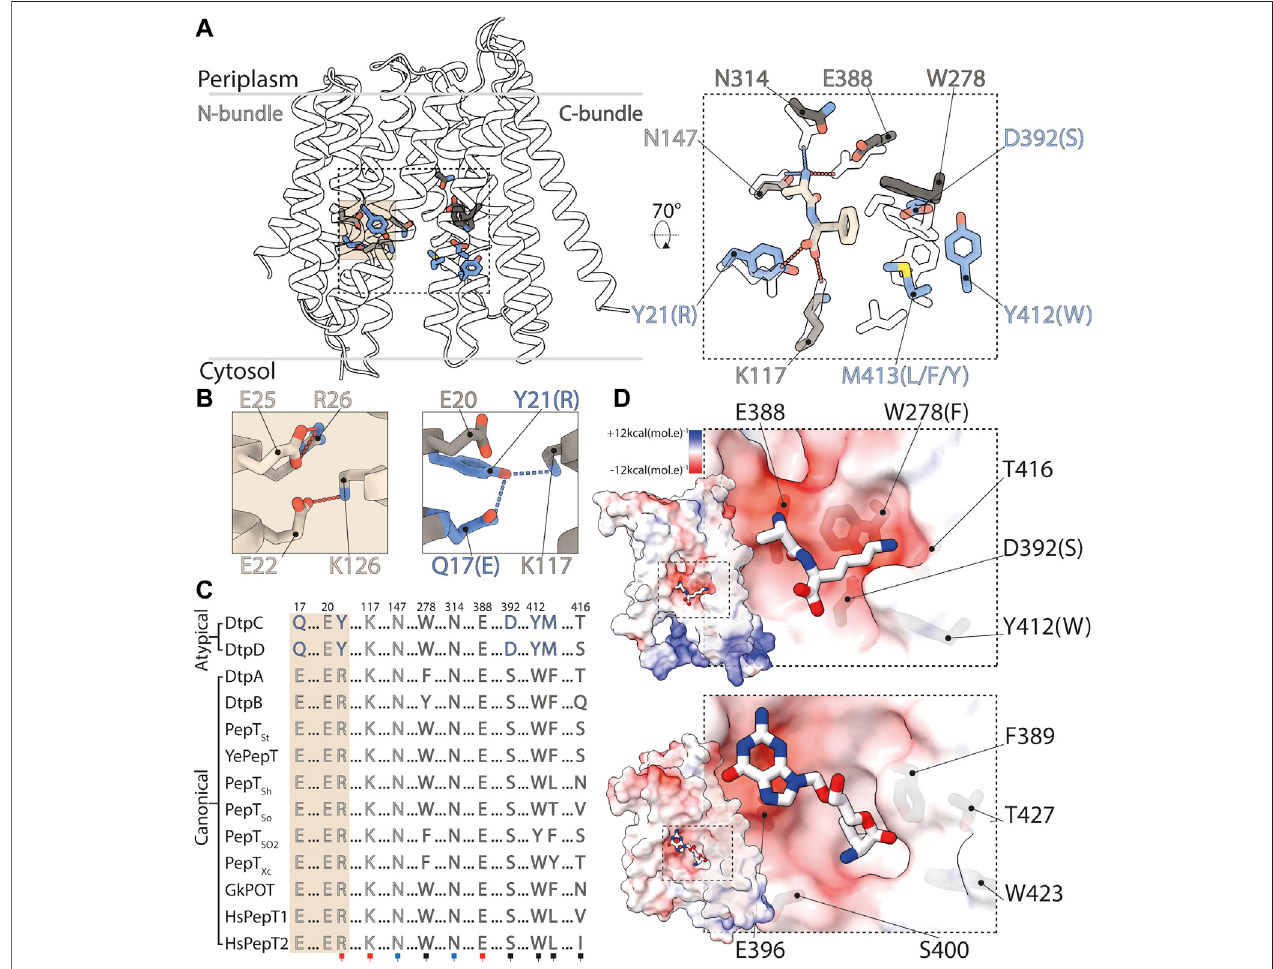
FIGURE 7 | Structural basis for ligand selectivity in DtpC and atypical POTs. (A) Key residues involved in substrate binding are colored and shown as sticks. In the close up view, an overlay of HsPepT2 (transparent residues) bound to the dipeptide Ala-Phe (beige) with DtpC is shown. Residues colored in grey are conserved while blue residues are exclusive to atypical POTs. (B) The arrangement of the E1XXE2R motif from PepT St is shown on the left panel, and the atypical Q1XXE2Y on the right. (C) The sequences of 13 POTs were aligned and residues involved in proton coupling and substrate binding are shown. The red squares mark residues strongly interacting with the charged termini of substrates peptides via salt bridges. The blue squares indicate two conserved asparagine residues stabilizing peptides through hydrogen bonds. The black squares point to residues constituting the side chain pocket of POTs, tuning ligand promiscuity or selectivity. (D) Surface representation coloredbyelectrostaticpotential,oftheC-bundlesofDtpC(toppanel)andDtpA(bottompanel).AposeofthepreferredsubstrateofDtpC,Ala-Lys,isproposed(top)and the co-crystallized valganciclovir drug hijacking canonical POTs isshown in DtpA (bottom). PDB accession codes ofpreviously published work: HsPepT2 bound to Ala- Phe: 7PMY; PepT St : 5OXO; DtpA bound to valganciclovir: